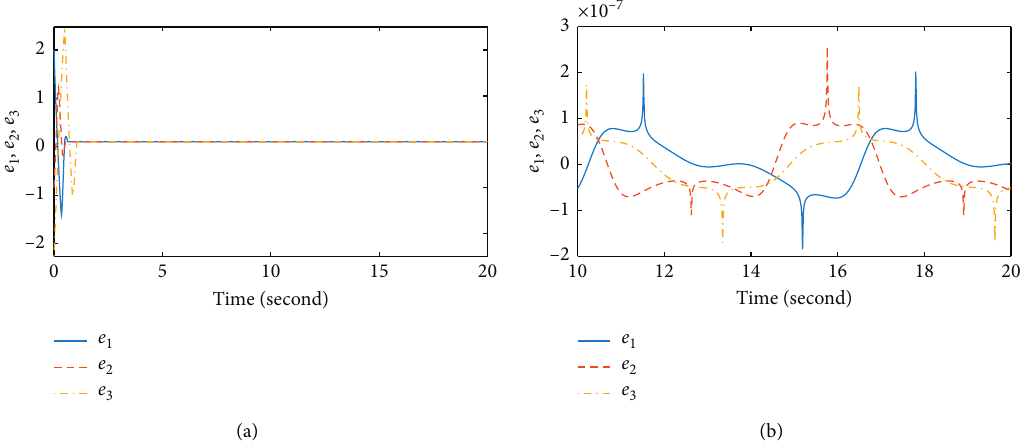
Figure 7: The trajectories of tracking error e